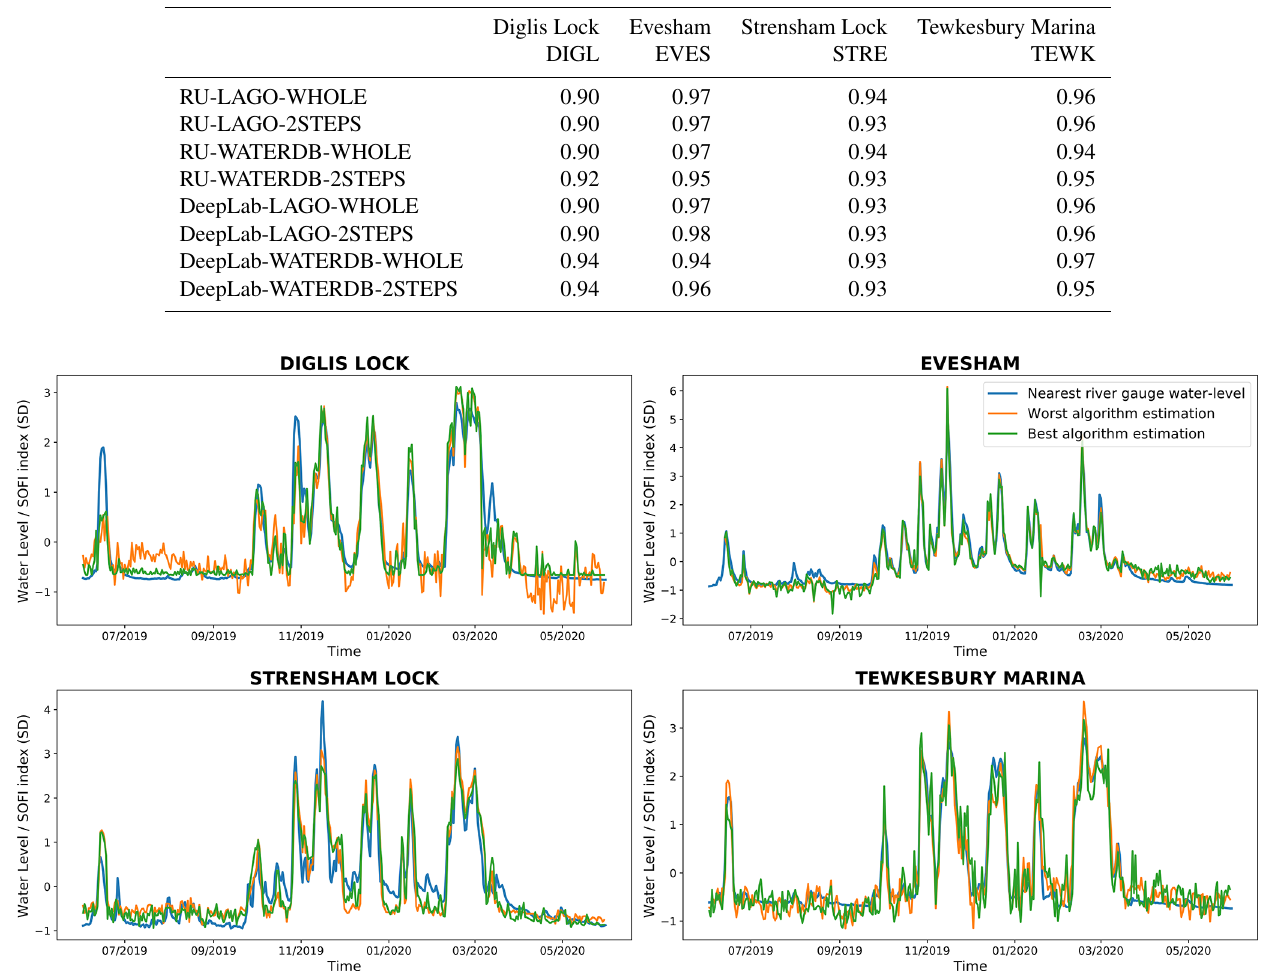
Table 7. Pearson’s correlation coefficients computed between the SOFIs of the best window from the 4 × 4 grid and the water levels obtained from the nearest river gauges.